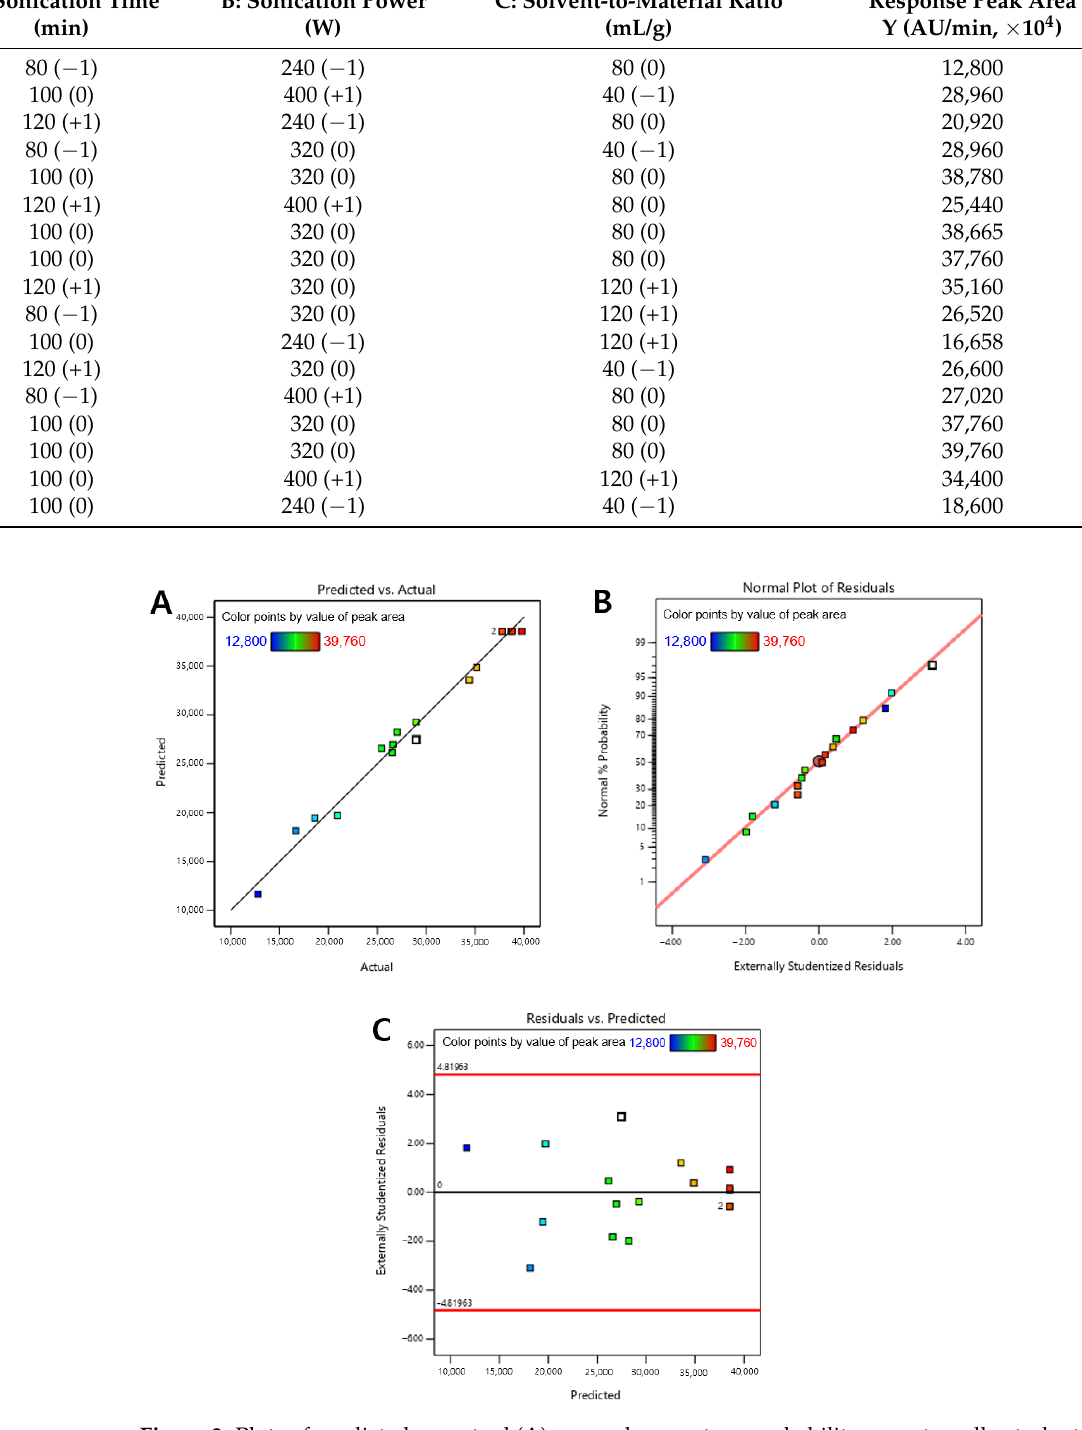
Figure 3. Plots of predicted vs. actual ( A ), normal percentage probability vs. externally studentized residuals ( B ), and externally studentized residuals vs. predicted response ( C ).